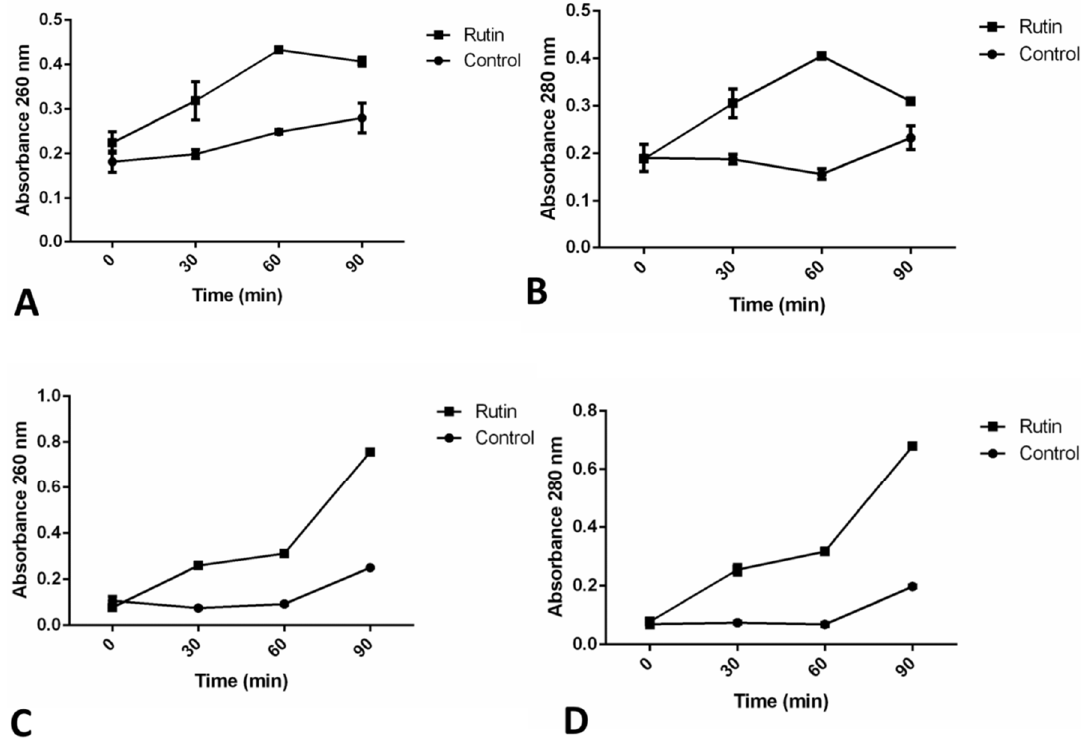
Figure 8. Leakage of intracellular material after treatment with rutin (MIC) as detected for P. aeruginosa IBRS P001 nucleic acids ( A ) and proteins ( B ), as well as for MRSA IBRS MRSA 011 nucleic acids ( C ) and proteins ( D ). The data are presented as mean ± SD.